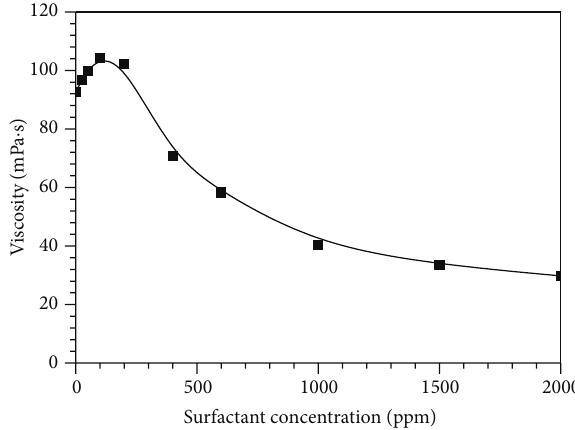
Figure 6: Effect of BS-12 concentrations on the viscosity of 1500 ppm HAPAM.